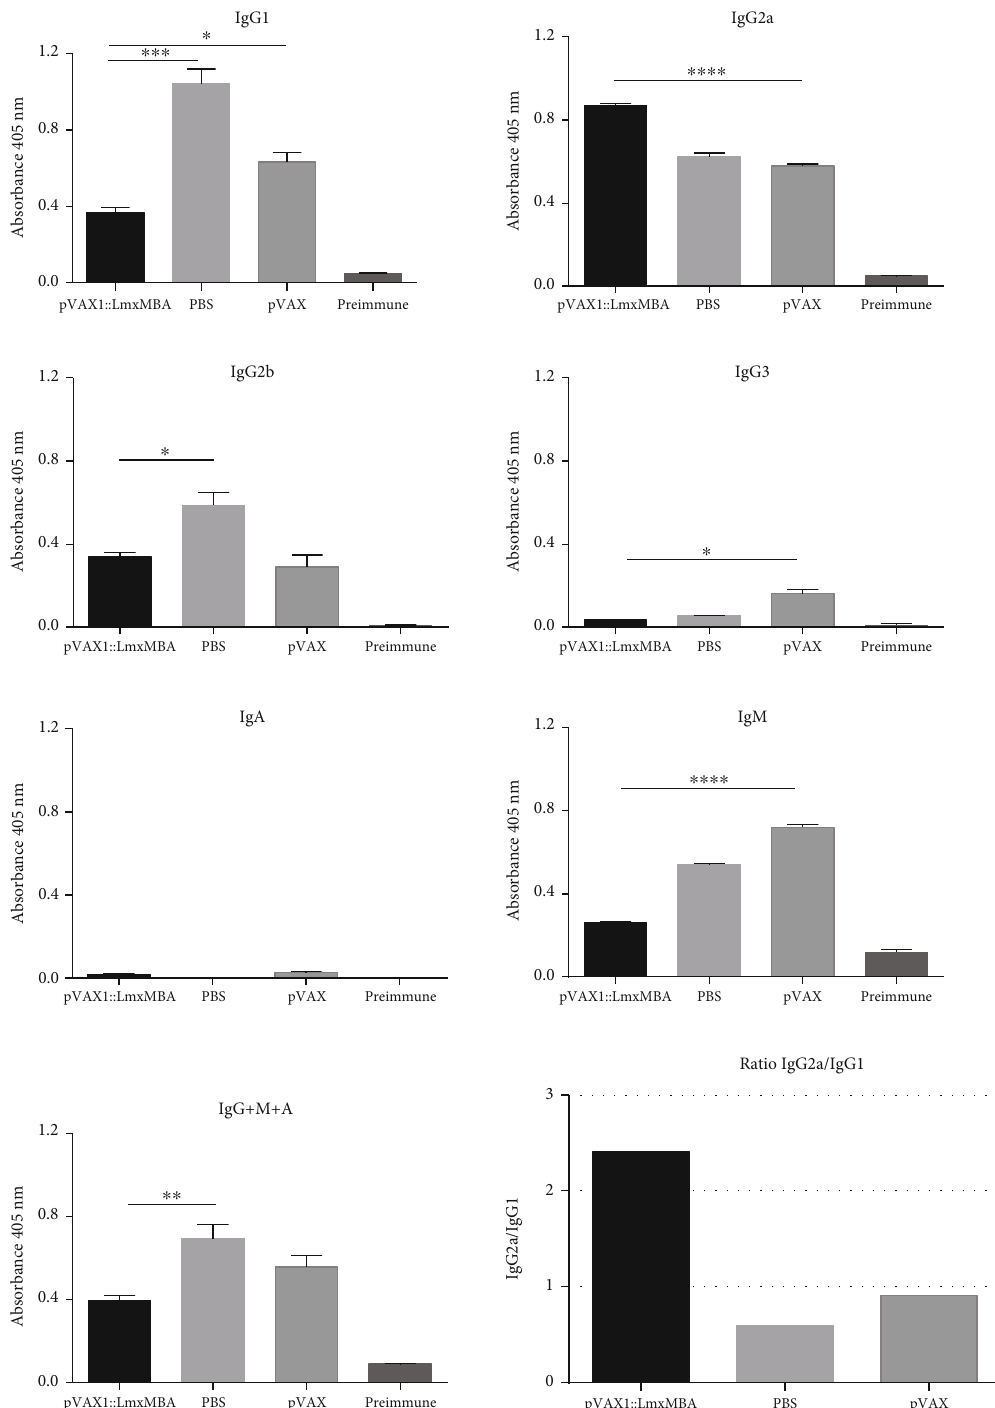
Figure 7: Vaccine-speci fi c serological responses. Serum samples were collected by cardiac puncture on day 105 post infection. Plates were coated with 2 μ g/ml of rLmxMBA, and serum samples were diluted 1: 100. Each bar represents the average ± standard deviation of optical densities. ∗ p < 0 : 05